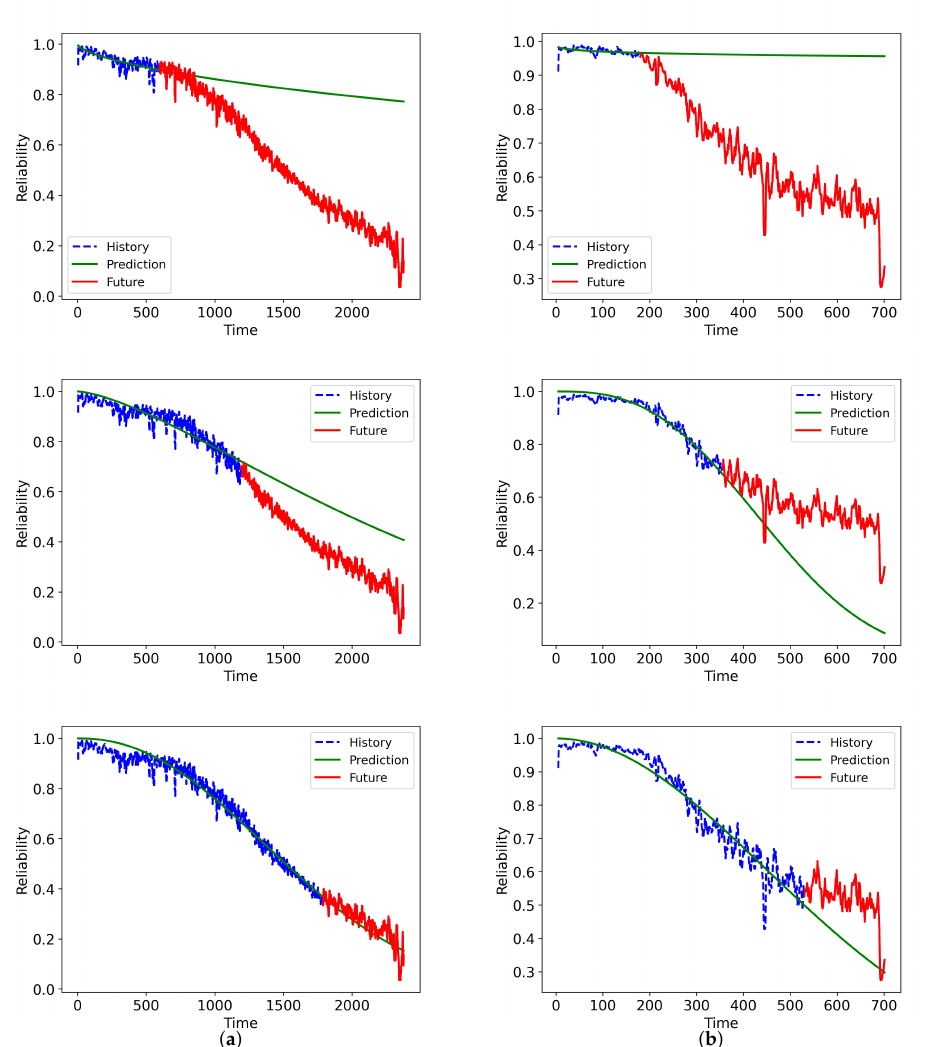
Figure 9. Learned reliability function from the historical data of 25%, 50%, and 75% during the whole degradation period: ( a ) Bearing 1_3; ( b ) Bearing 2_6.